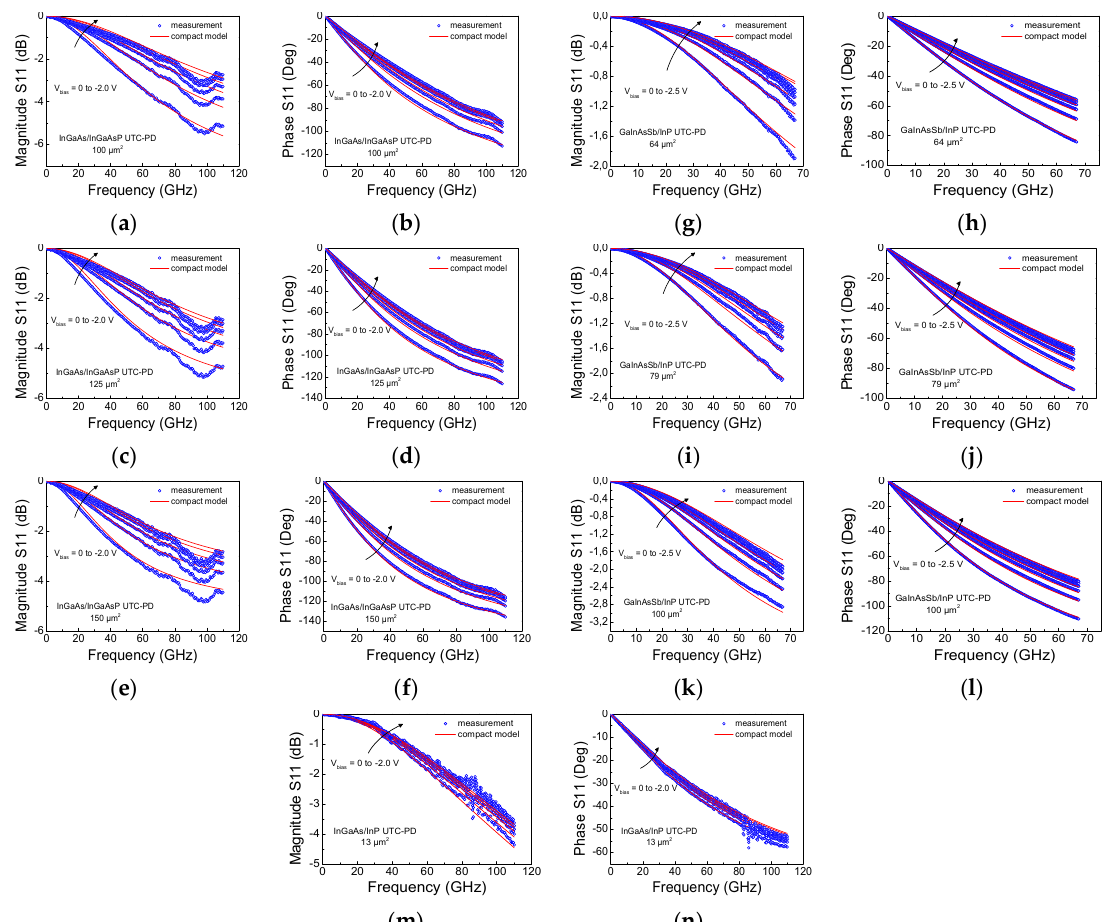
Figure 10. Measured (symbol) and simulated (lines) intrinsic S11-parameter for all the UTC-PDs technologies: ( a , c , e ) magnitude in dB of InGaAs/InGaAsP UTC-PD with actives areas of 100, 125 and 150 µ m 2 ; ( b , d , f ) phase in degree of InGaAs/InGaAsP UTC-PD with active area of 100, 125 and 150 µ m 2 ; ( g , i , k ) magnitude in dB of GaInAsSb/InP UTC-PD with active area of 64, 79 and 100 µ m 2 ; ( h , j , l ) phase in degree of GaInAsSb/InP UTC-PD with active area of 64, 79 and 100 µ m 2 ; ( m ) magnitude in dB of InGaAs/InP UTC-PD with a 13 µ m 2 active area; ( n ) phase in degree of InGaAs/InP UTC-PD of 13 µ m 2 of active area.